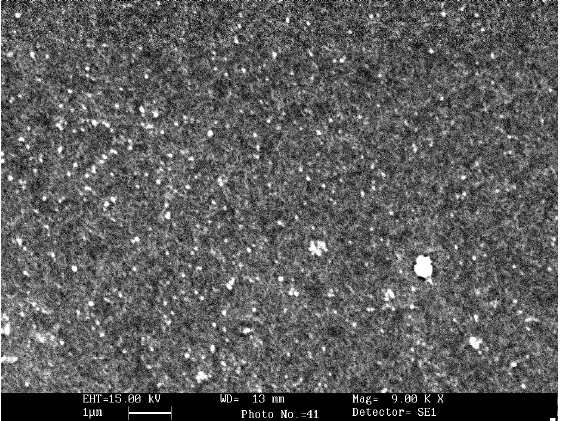
Figure 7 . The scanning electron micrographs of thin film deposited at 363K-substrate